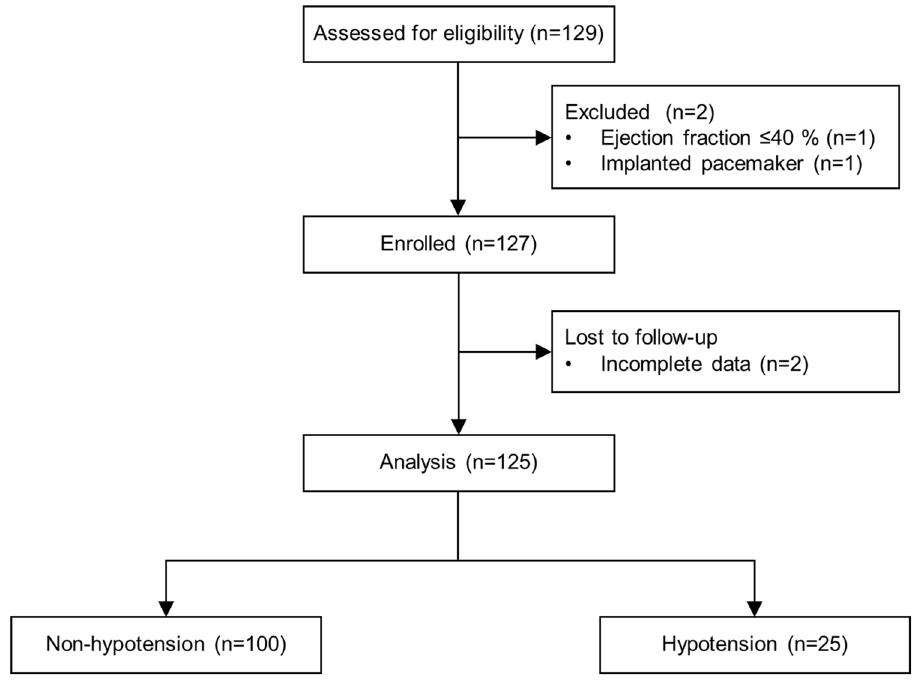
Figure 1. CONSORT flow